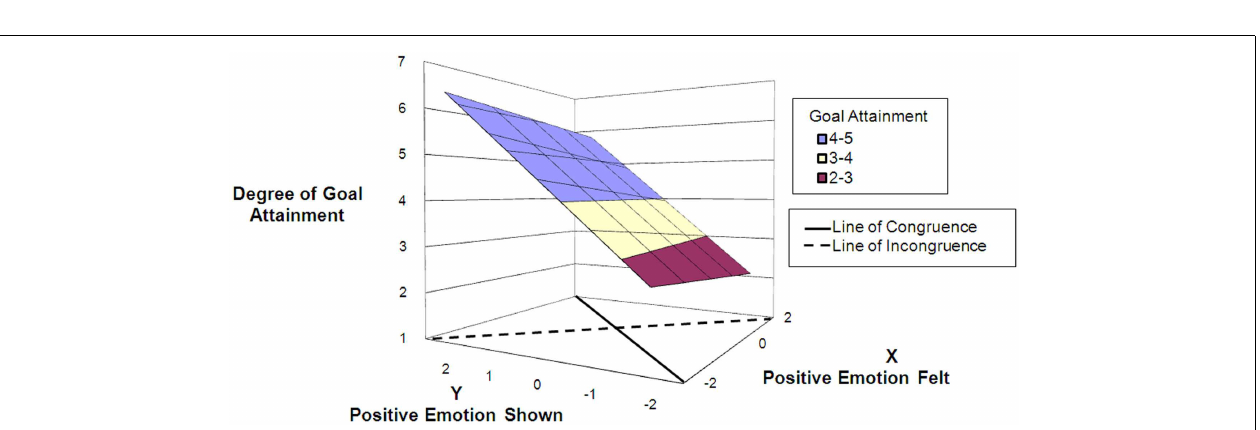
FIGURE 2 | Predicting goal attainment by positive emotions felt and shown during interactions at work.